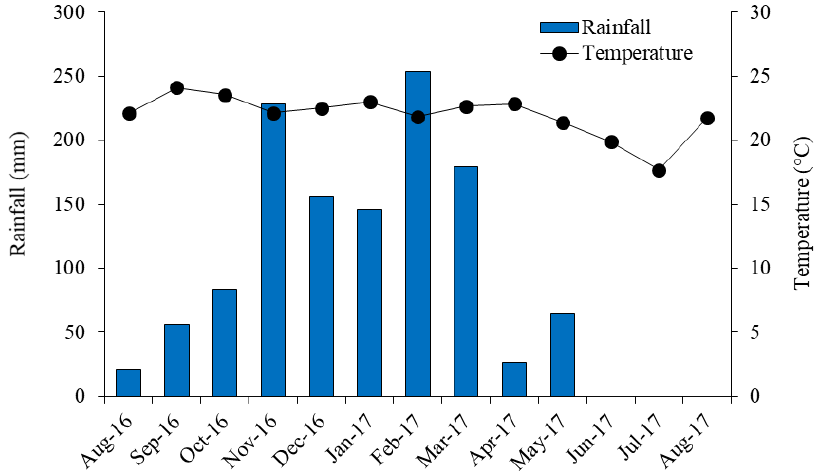
Figure 3. Monthly rainfall and air temperature in the Lake Paranoá catchment area.